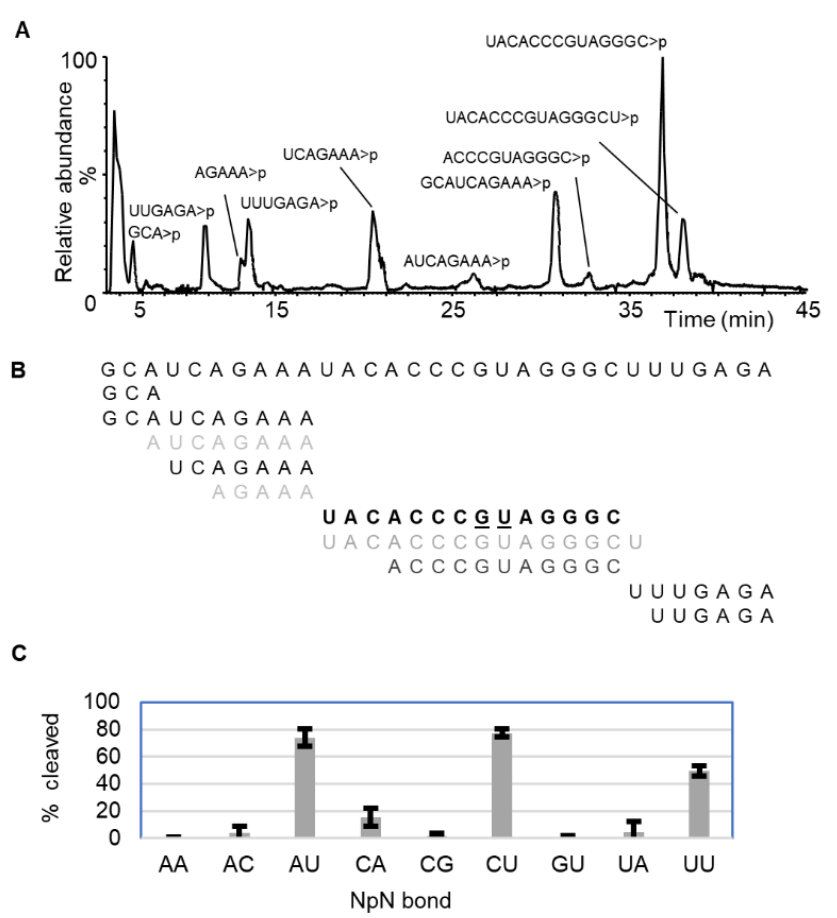
Figure 1. Dinucleotide sequence-dependent RNA cleavage by RNase MC1. ( A ) Total ion chromatogram (TIC) annotated with the observed digestion products containing cyclic phosphates (> p ). ( B ) Overlay of the observed digestion products mapped to the original sequence. ( C ) Dinucleotide bonds cleaved by the MC1. Cleavage efficiency is the percentage of abundance (peak area) ratio of the expected/observed digestion product upon cleavage of specific dinucleotide and that of the undercut sequences overlapping respective bonds. Table 1. RNA cleavage preferences of MC1 and cusativin. Cleaved dinucleotide bonds are shown.